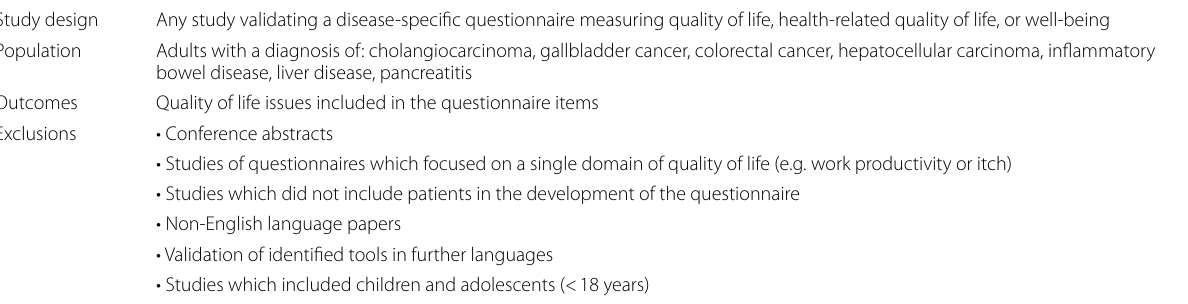
Table 1 Study eligibility criteria for the literature review of validated questionnaires Study design